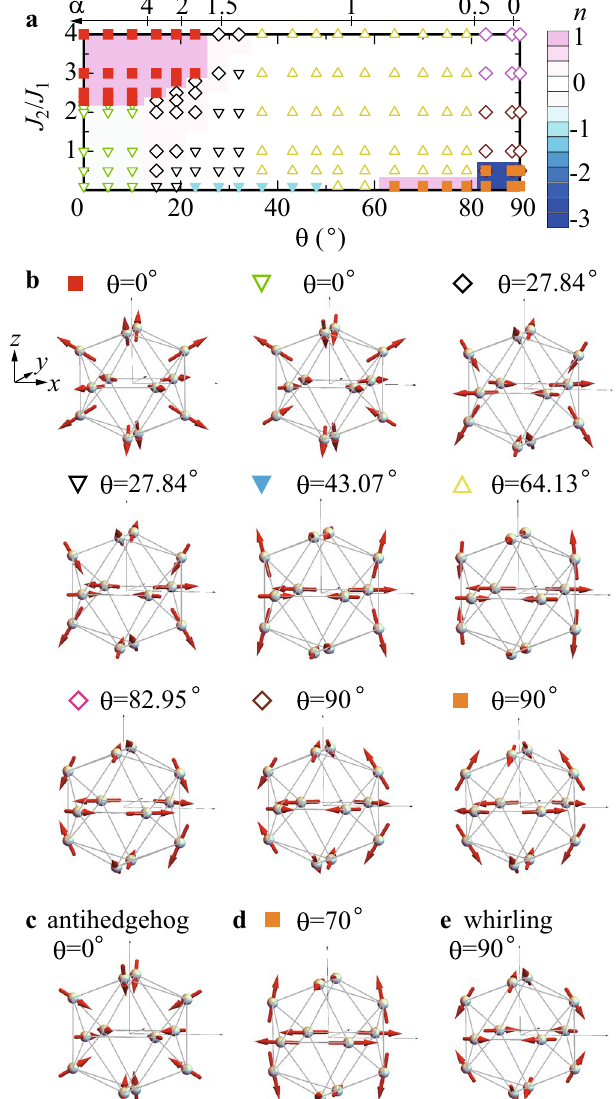
Figure 3. Ground-state phase diagram and magnetic textures in icosahedron. ( a ), The ground-state phase diagram for J 2 / J 1 ( J 1 < 0 ) and θ as well as α in the icosahedron. Contour plot of the topological charge n is also shown. ( b ), Magnetic texture shown by each symbol in ( a ). ( c ), Antihedgehog state for θ 70 state for θ ◦ . ( e ), Whirling state for θ = =